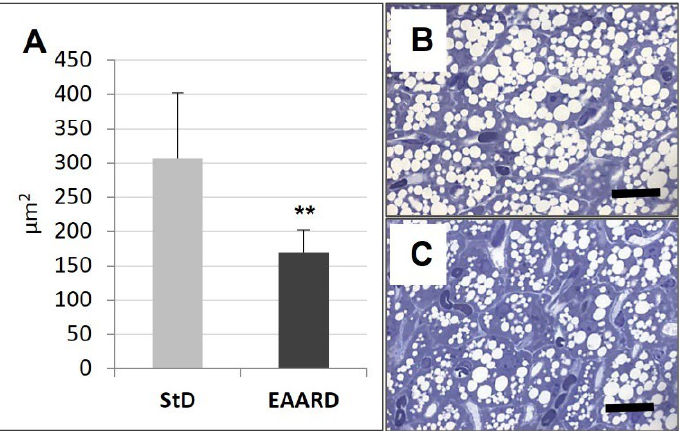
Figure 10. ( A ): Mean (± sd) BAT adipocyte area ( t = 9.486, p = 0.000) according to diet. ** p < 0.01. ( B , C ): Representative images of semithin BAT sections toluidine blue stained from StD and EAARD, respectively. EAARD-fed mice shown the dramatic reduction in lipid droplets. Original magnification 100×; scale bar 50 μm.